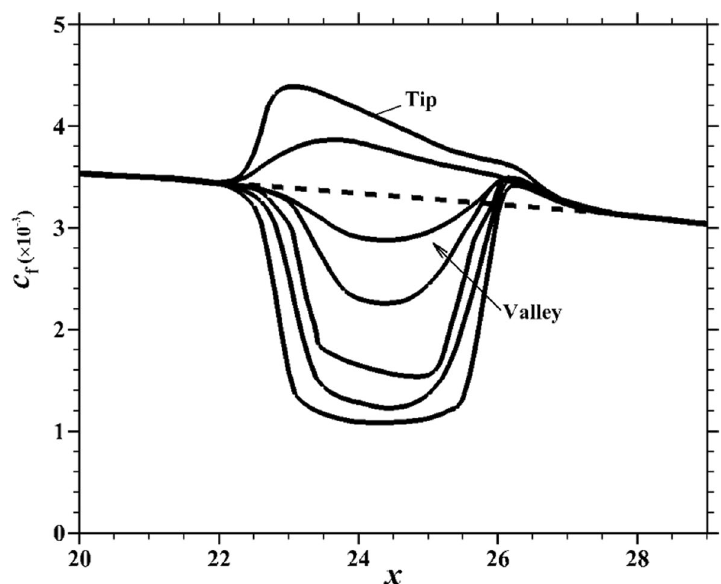
Fig. 10 Streamwise development of local friction drag coefficient on riblets (solid lines) and smooth (dashed line) flat-plate cases